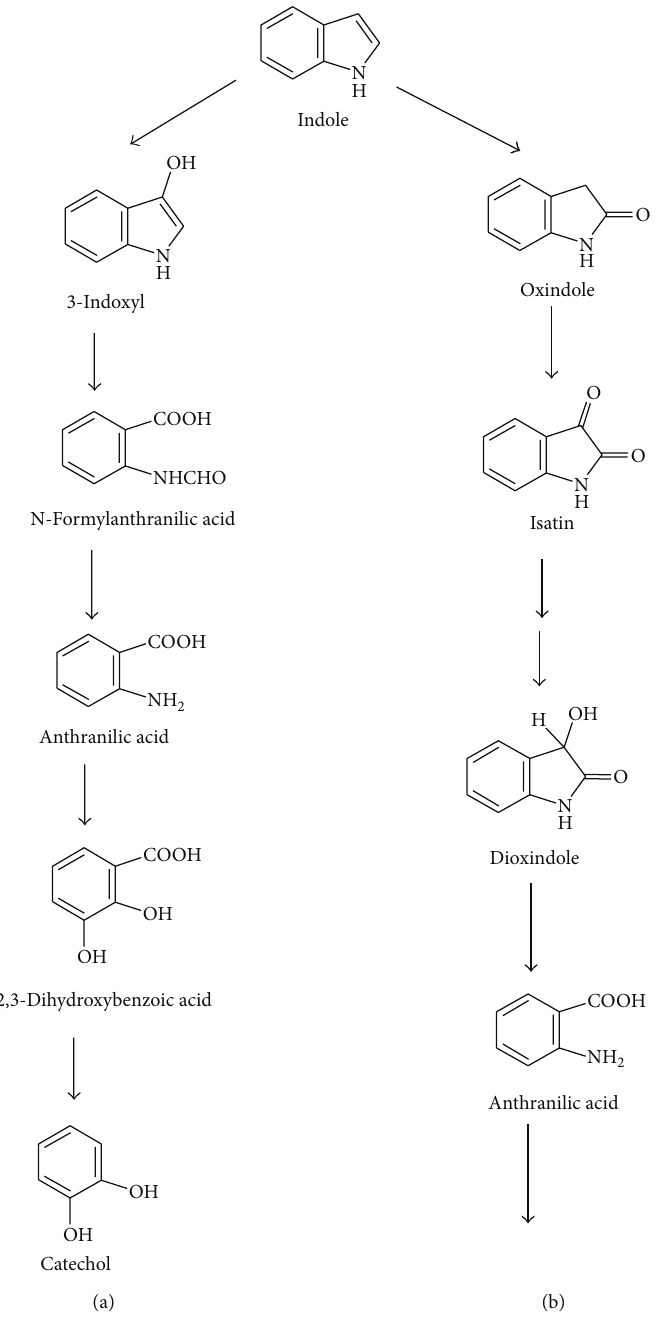
Figure 4: Fungal degradation pathways of indole in (a) Aspergillus niger [12] and (b) Phomopsis liquidambari [38].